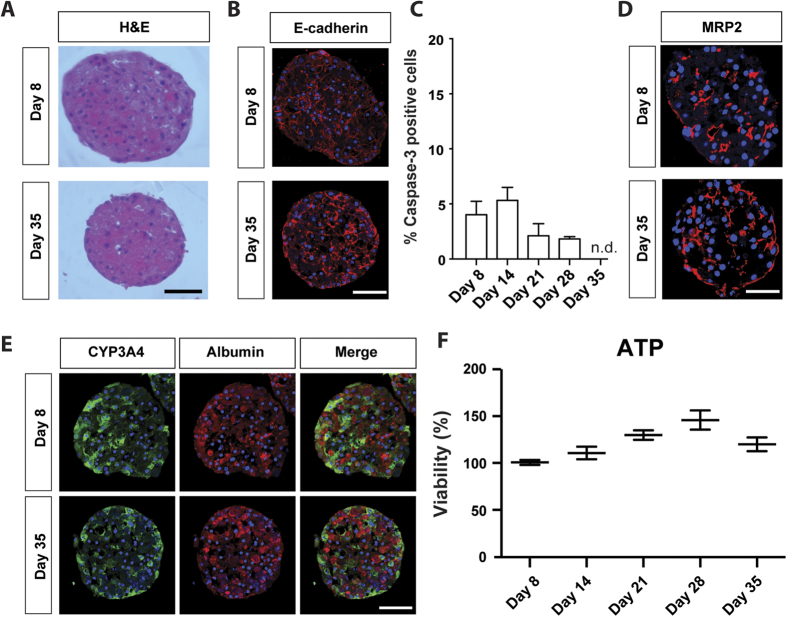
PHH spheroids can be maintained for at least 5 weeks in serum-free conditions.(A) H&E staining of PHH spheroids. Note that spheroid sizes decreased coinciding with increased expression of E-cadherin (B), which has been previously shown to promote spheroid compaction5. (C) Levels of cleaved caspase-3, a marker for apoptosis, remained at low levels throughout the culture period as determined by immunohistochemistry. (D) MRP2 immunostaining revealed bile canaliculi at early as well as late stages of spheroid culture. (E) Staining for the perivenous marker CYP3A4 and the periportal marker albumin reveals that the zonation-identity of liver cells is maintained. (F) Cellular ATP levels remained constant throughout 5 weeks of culture (n = 20 spheroids from 3 donors per time point). Absolute ATP values were normalized to spheroid volume to compensate for compaction. All scale bars = 100 μm.